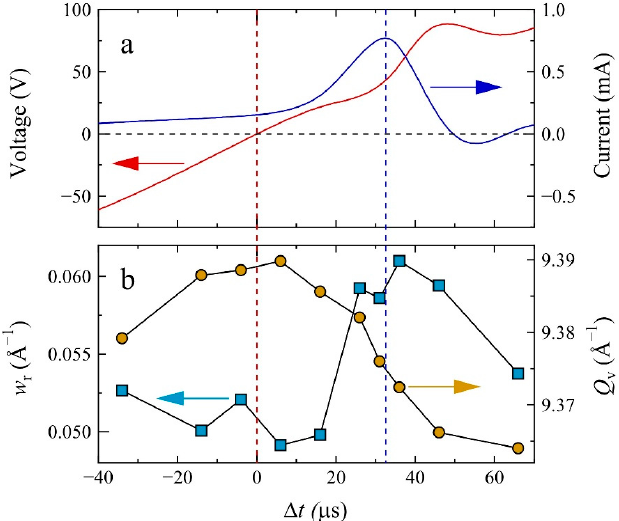
Figure 2. Time ( ∆ t ) dependences of ( a ) Q r and ( b ) Q v one-dimensional profiles of the 006 Bragg peak through the intensity maxima in the time-resolved XRD for average structure under AC field. Profiles before, during, and after polarization switching are colored in red, green, and blue, respectively.